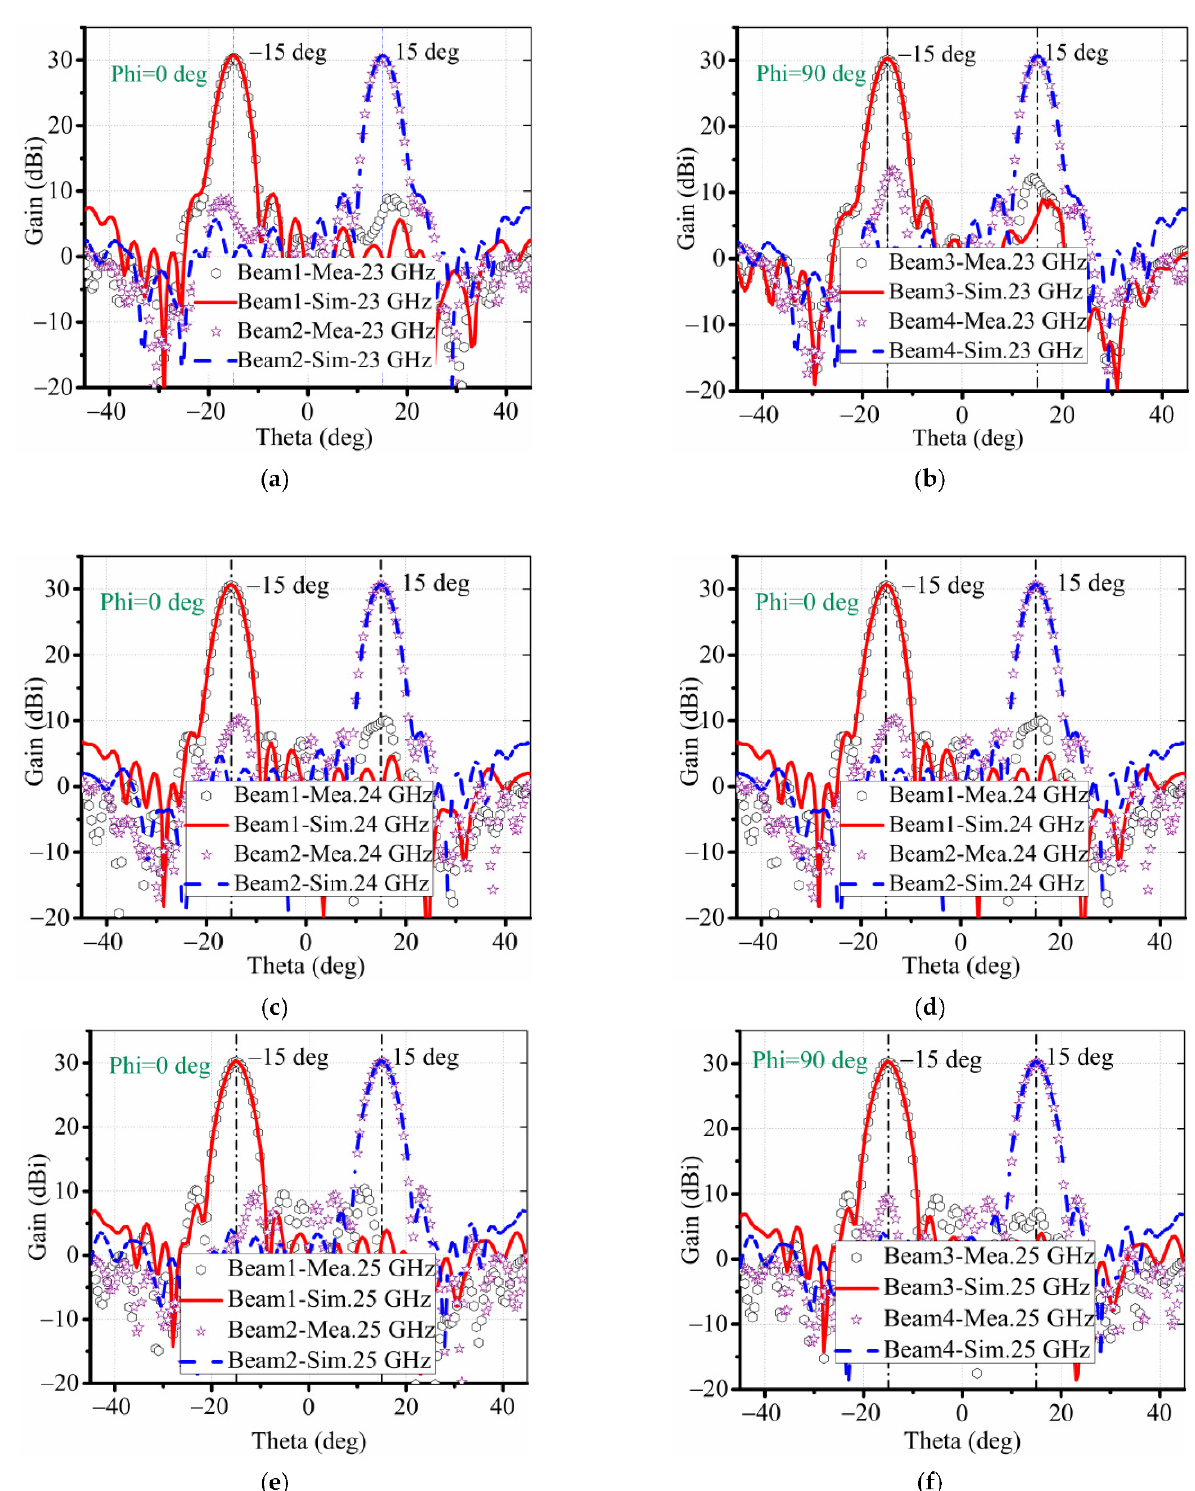
Figure 8. Radiation patterns of different frequencies with different beams. ( a , b ) 23 GHz. ( c , d ) 24 GHz. ( e , f ) 25 GHz.